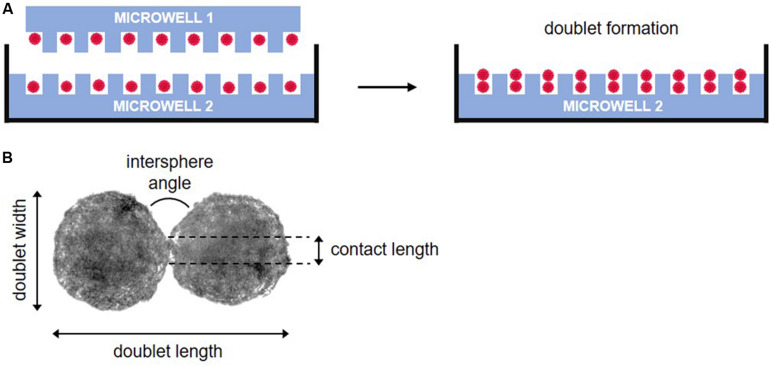
Schematic representation of doublet fusion assay. (A) Spheroids are pairwise placed by inverting a donor microwell (microwell 1) on top of a recipient microwell (microwell 2) and after centrifugation, the donor microwell was removed, leaving spheroid doublets in microwell 2. (B) Morphological parameters measured during fusion.